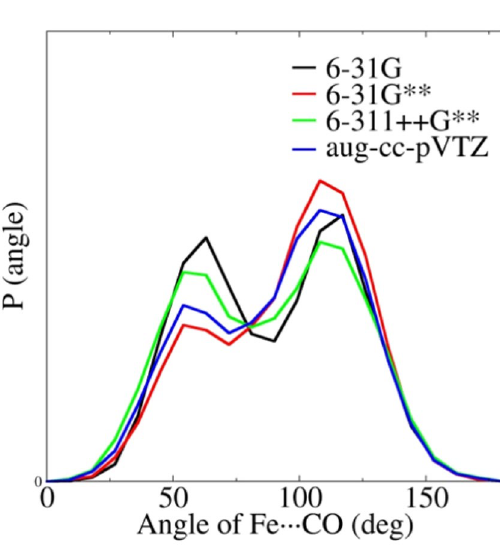
Figure 3. The distribution of the Fe  C ≡ O angle for the QM/MM MD simulations at the B3LYP with various basis sets of 6–31 G, 6–31 G ** , 6–311 ++ G ** , and aug-cc-pVTZ QM/MM